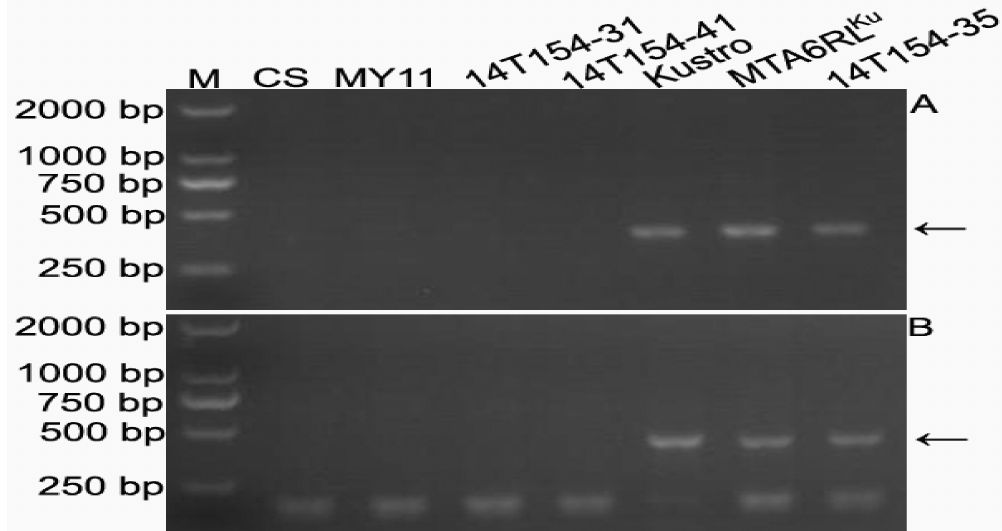
Figure 4. Representative results of developing 6RL Ku minichromosome-specific markers. ( A ) Products amplified marker 6RL-M55. ( B ) Products amplified marker 6RL-M63. M, DNA marker. Arrows indicate 6RL Ku minichromosome-specific bands.